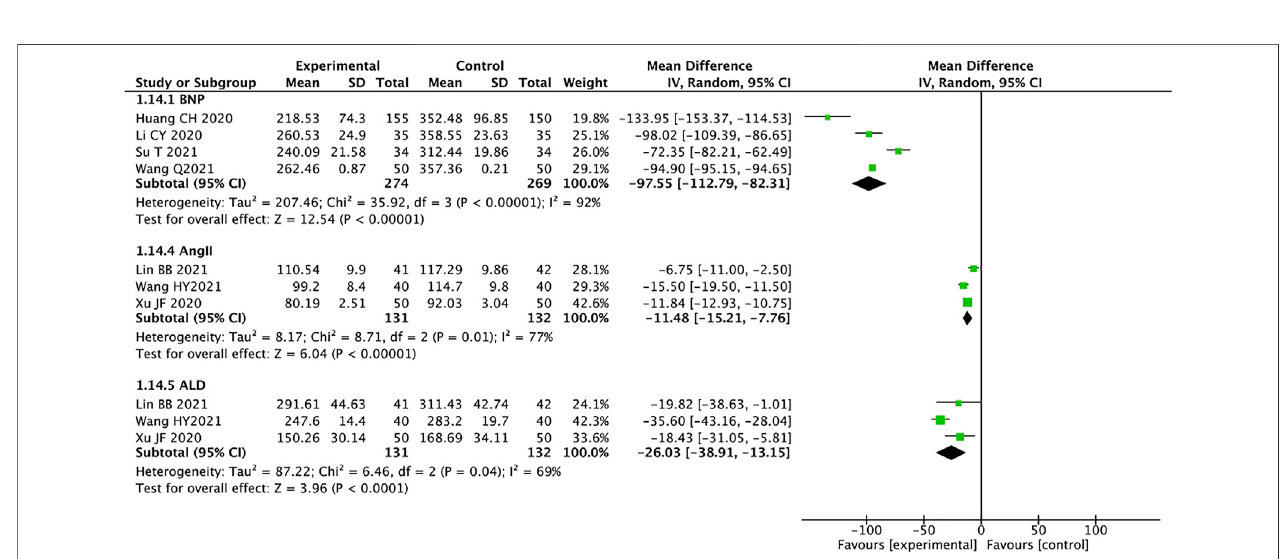
FIGURE 9 | Forest plot of BNP, AngII, and